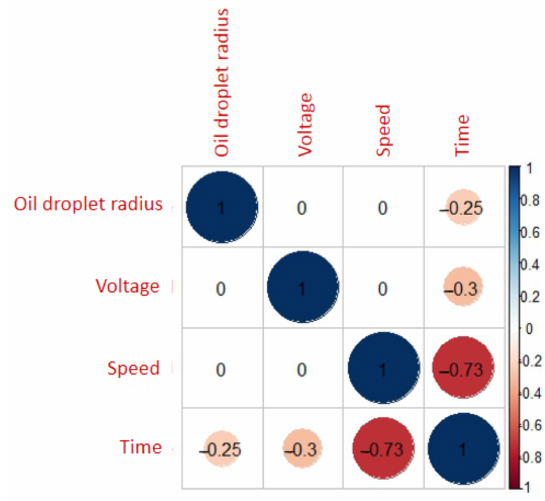
Figure 12. Matrix correlation